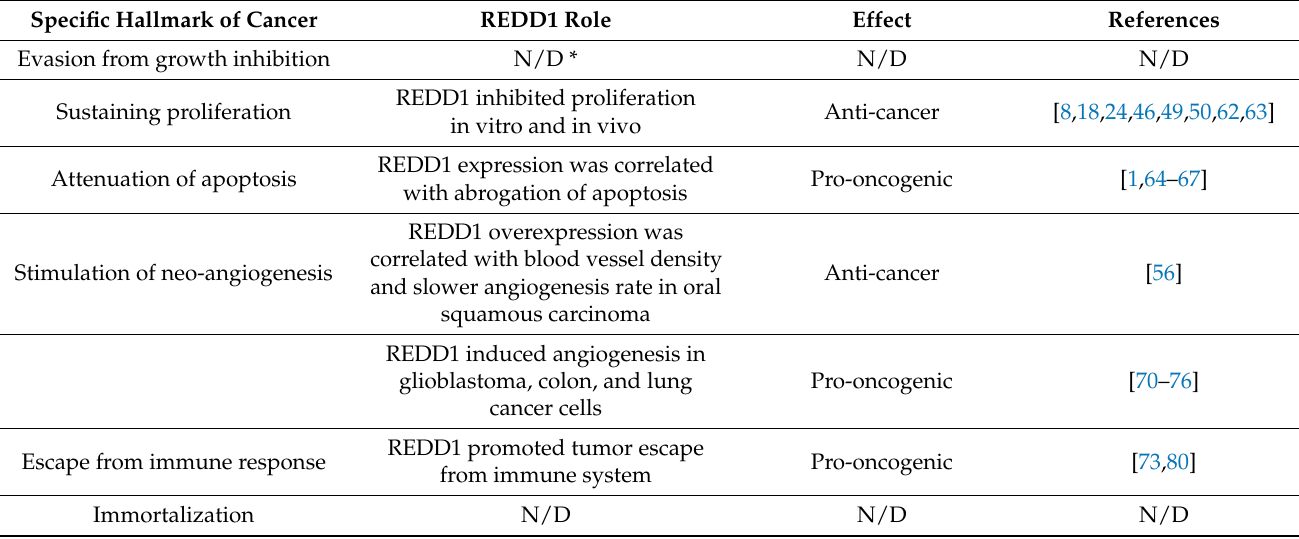
Table 1. REDD1 role in